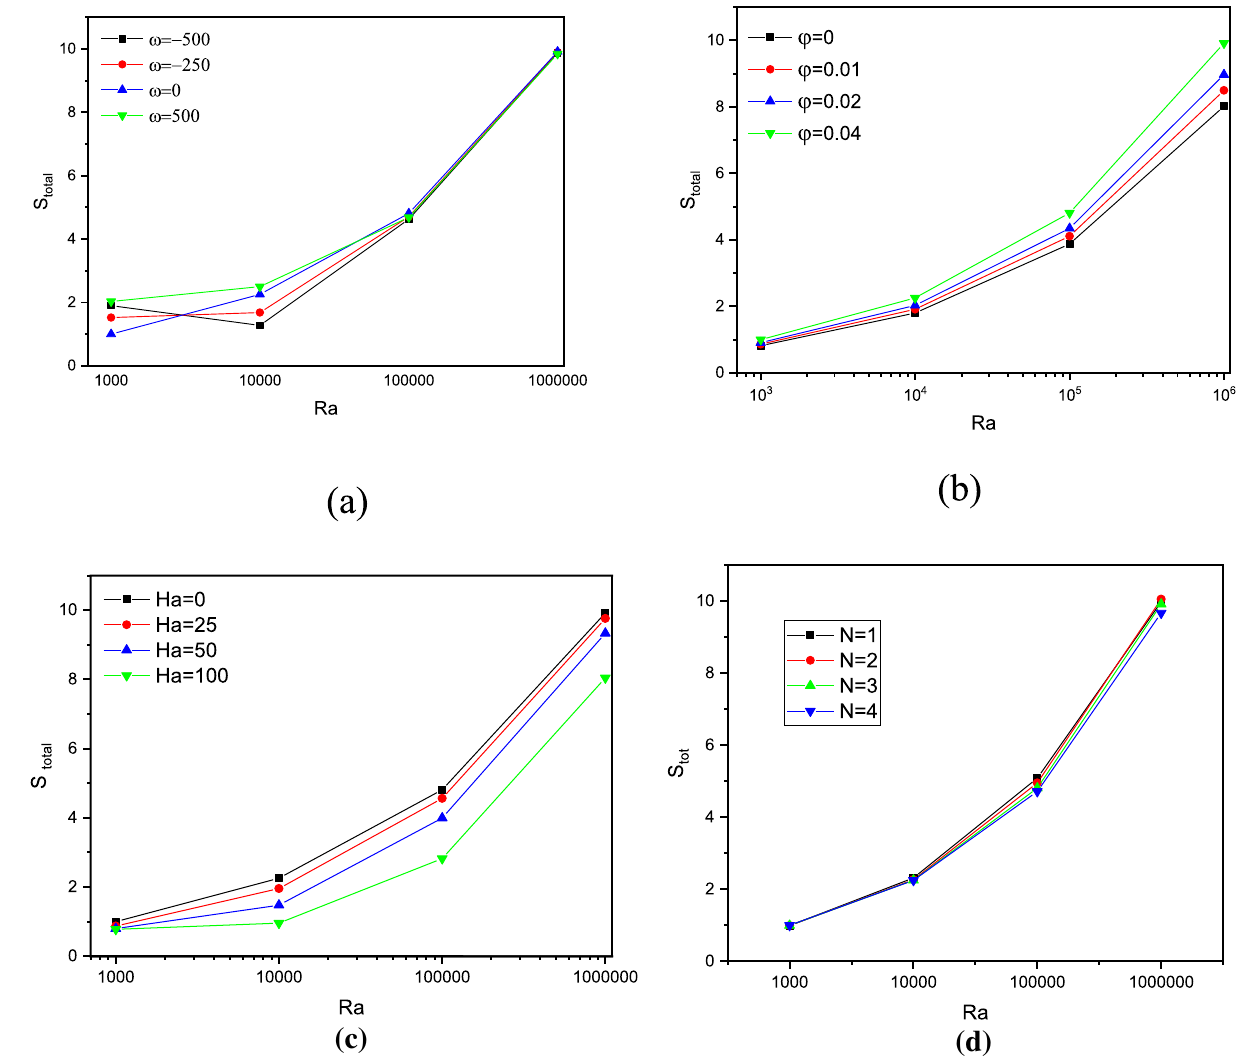
Figure 8. Impact of Ra on S Total function with varying Ω ( a ), ϕ ( b ) and Ha ( c ) at N =